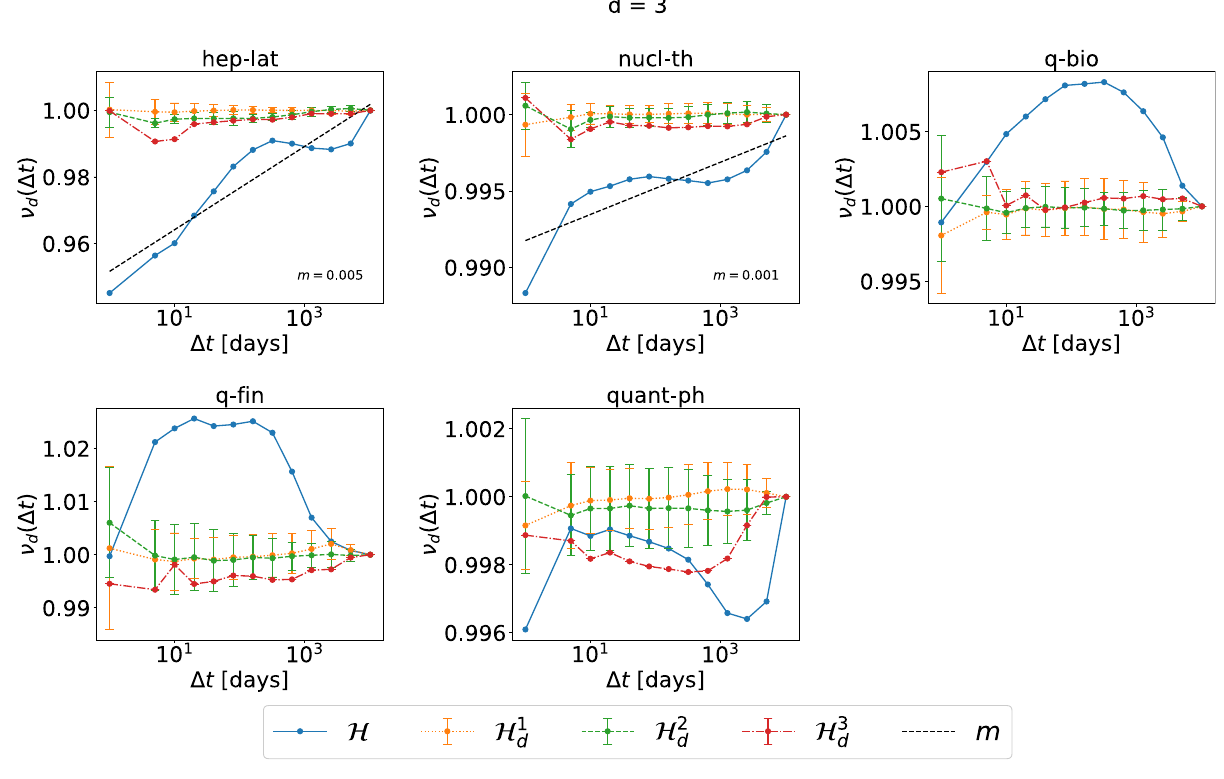
E [ η( e , e ′ ) | T ( e , e ′ )<� t , e , e ′ ∈ E d ] Figure 4. The normalized average topological distance ν d (� t ) = E [ η( e , e ′ ) | e , e ′ ∈ E d ] , between two order d = 3 events, in each collaboration network and its corresponding three randomized null models H 1 d (yellow), H 2 d (green) and H 3 d (red), which preserve or destroy specific properties of order d = 3 events. lim � , e ′ ) | T ( e , e ′ ) < � t , e , e ′ ∈ E , e ′ ) | e , e ′ ∈ E t →∞ E [ η( e d ] = E [ η( e d ] for any d . The horizontal axes are presented in logarithmic scale. The dashed line in each figure corresponds to the linear fit (with slope m ) of ν d (� t ) as a function of log 10 (� t ) in H , for the part that the curve has an increasing trend. For each dataset, the results of the three corresponding randomized models are obtained from 10 independent